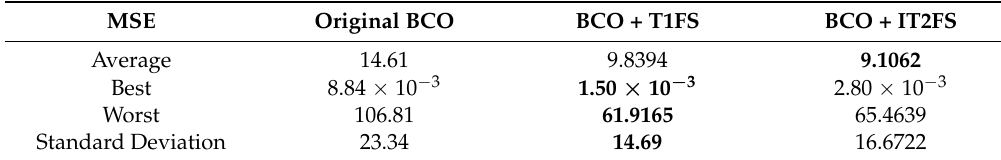
Table 8. Comparison of results of the plant without noise for the BCO.